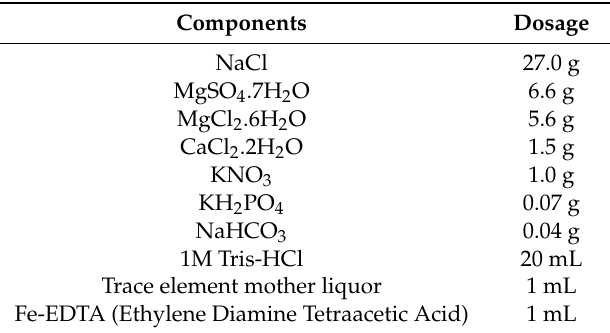
Table 2. Artificial seawater components (1